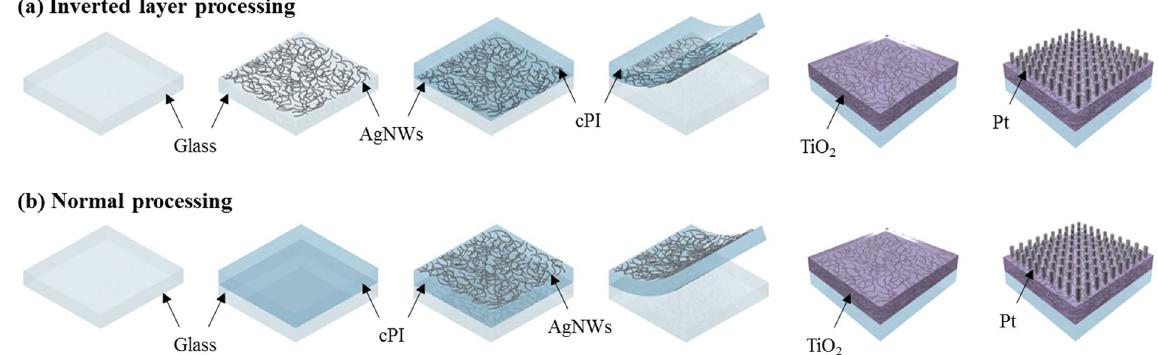
Figure 1. Schematic of the fabrication procedure for AgNWs/cPI-based FT-RRAMs: ( a ) inverted layer processing and ( b ) normal